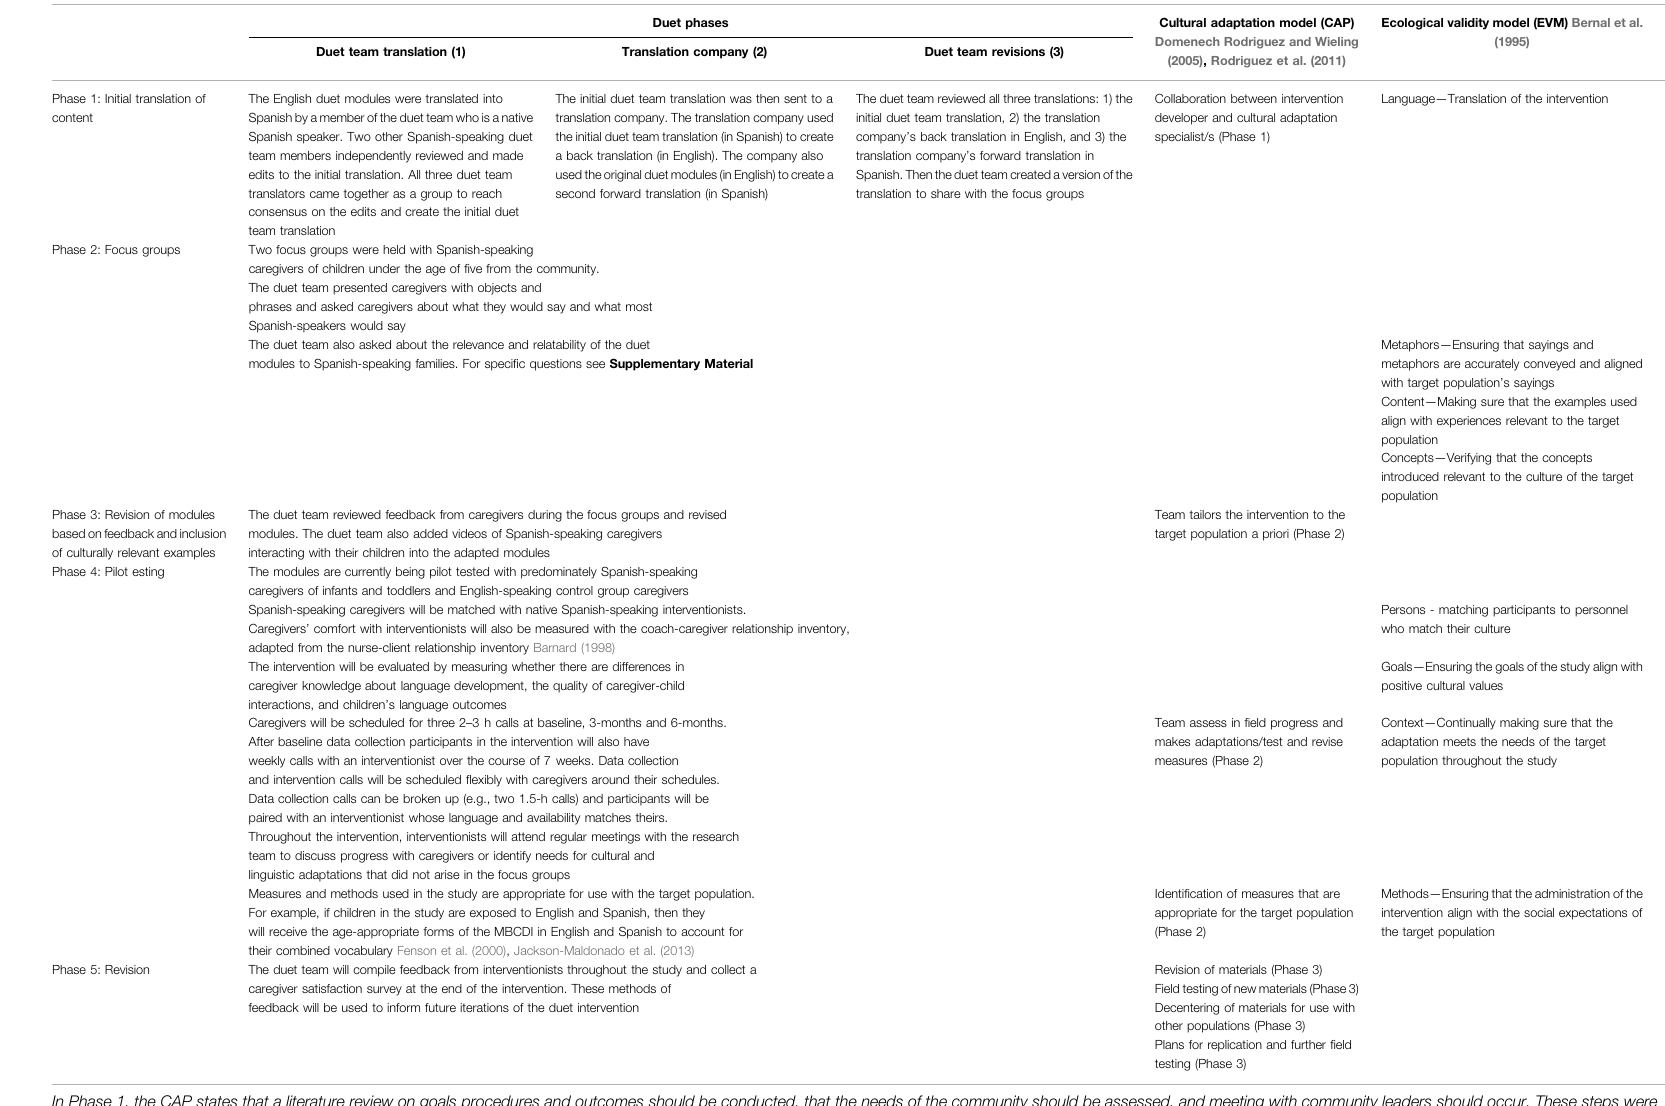
TABLE 1 | Duet 2.0 adaptation